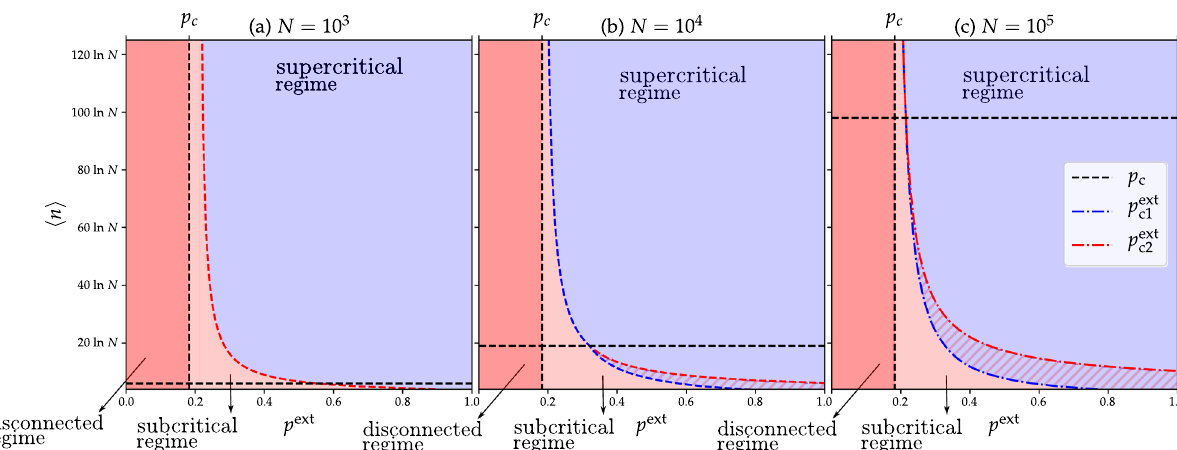
Fig. 4 Phase diagram of a quantum Erd ő s-Rényi network. Depicted are phase diagrams of h n i = ln N versus the probability that a link is not removed p ext for a quantum Erd ő s-Rényi network network comprised of N = 10 4 ( a ), 10 5 ( b ), and 10 6 ( c ) nodes, respectively, with c = 6 average degree and α = 1. Here we assume the number of entangled pairs in each link follows an exponential distribution with mean 〈 n 〉 . The functionally supercritcal regime is represented as the blue region while the functionally subcritical regime is the light red region. Further the stripped (blue/light red) area represents the region where both the functionally connected and subcritical regime are stable. The dark red region represents the structurally disconnected regime. Next the classical percolation critical probability p c is the point where the networks breaks completely apart, meaning there is no giant set of nodes that can connect to each other with any fi delity. Also shown are the critical mean resource number n c = ln N for which the discontinuous phase transition is avoided.